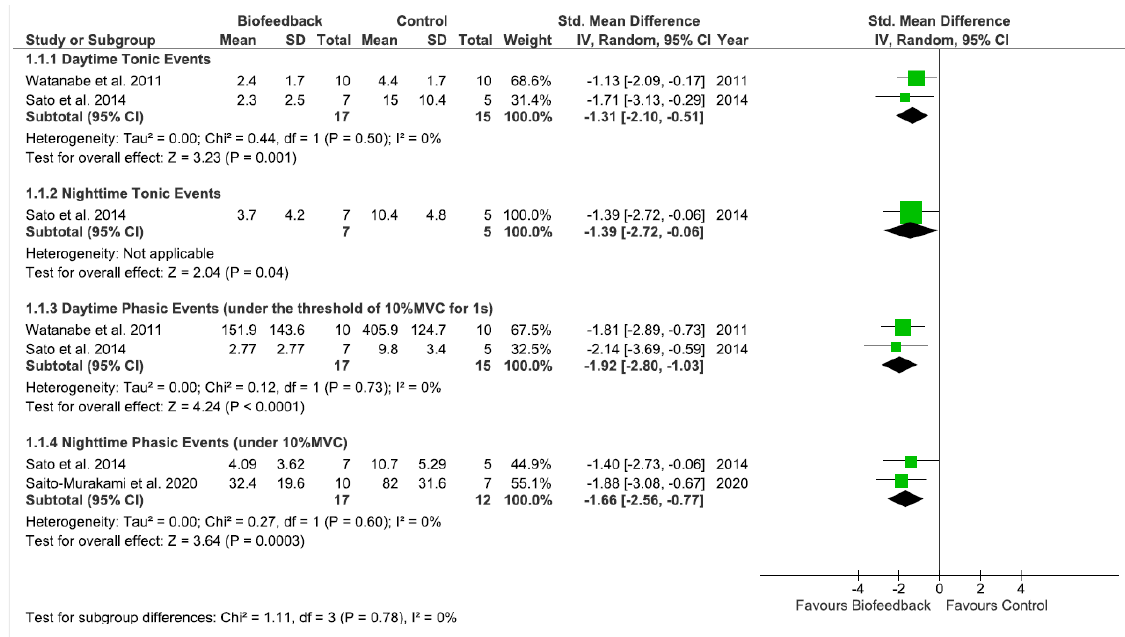
Figure 3. Day and night times phasic and tonic events of bruxism activity: Biofeedback training vs. control groups evaluated through EMG activity [24,32,33]. Table 2. GRADE “Biofeedback compared to control intervention for Awake Bruxism”.